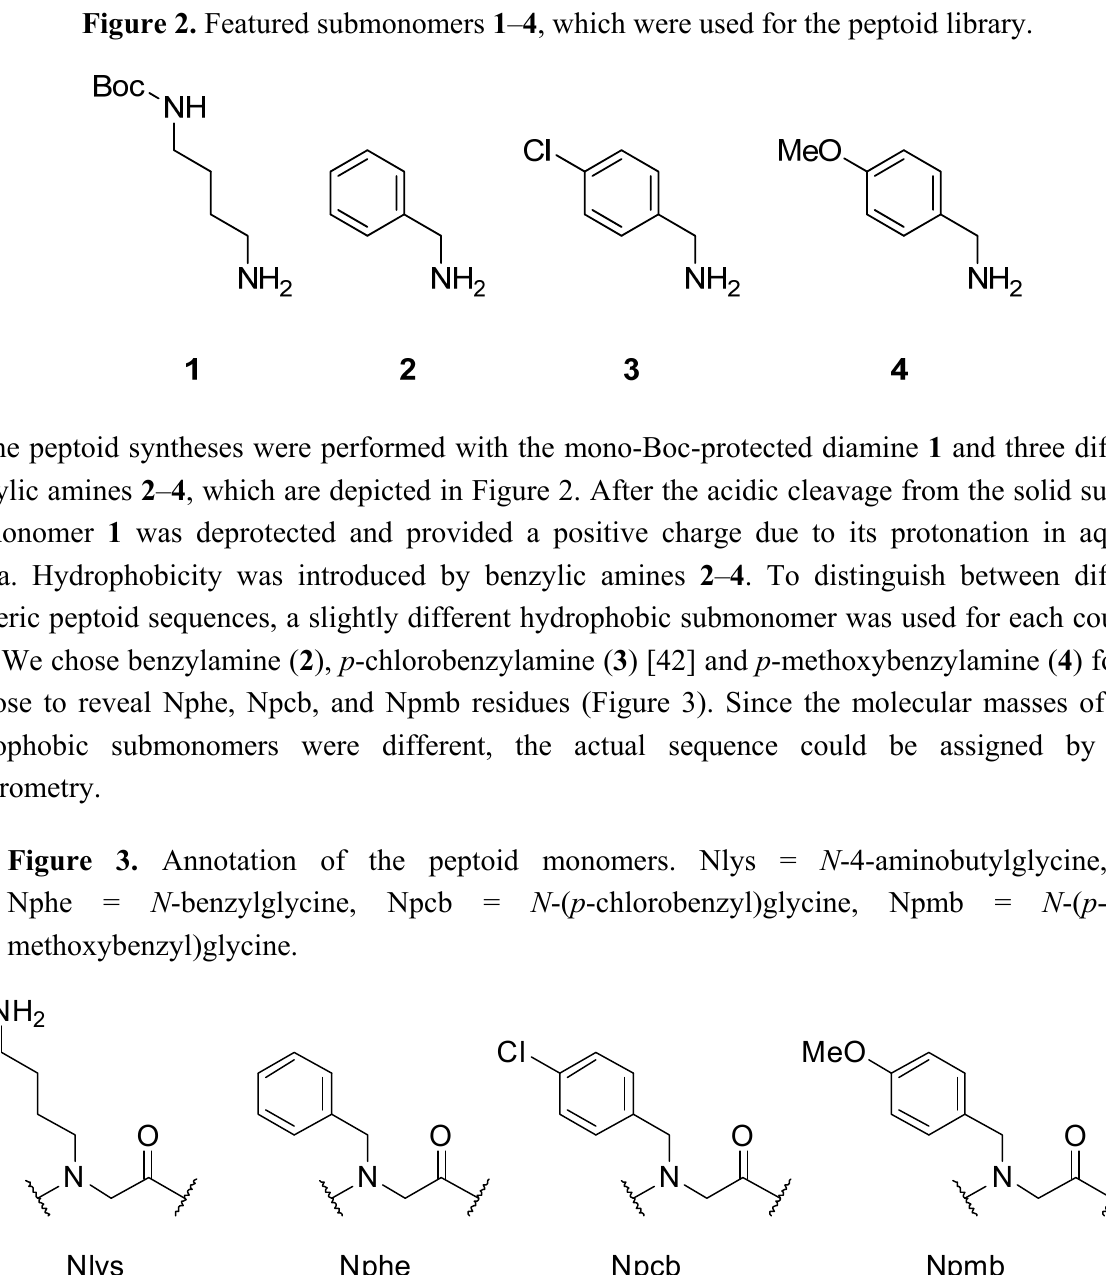
Figure 2. Featured submonomers 1 – 4 , which were used for the peptoid library.